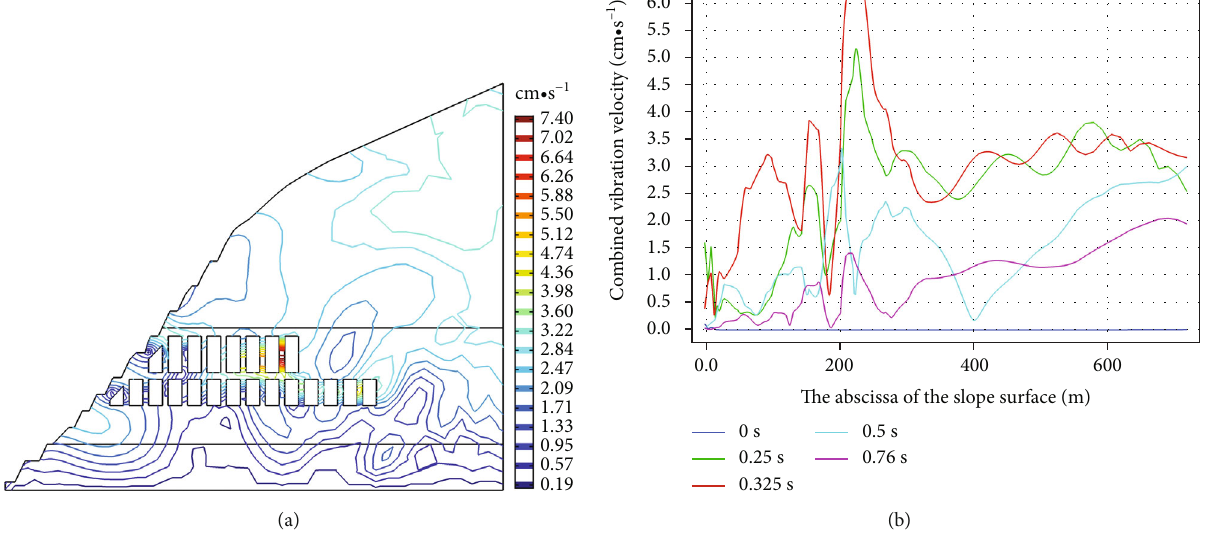
Figure 8: Combined vibration velocity caused by blasting vibration: (a) contour plot of slope combined vibration velocity when t = 0 : 265 s ; (b) combined vibration velocity of the surface of the